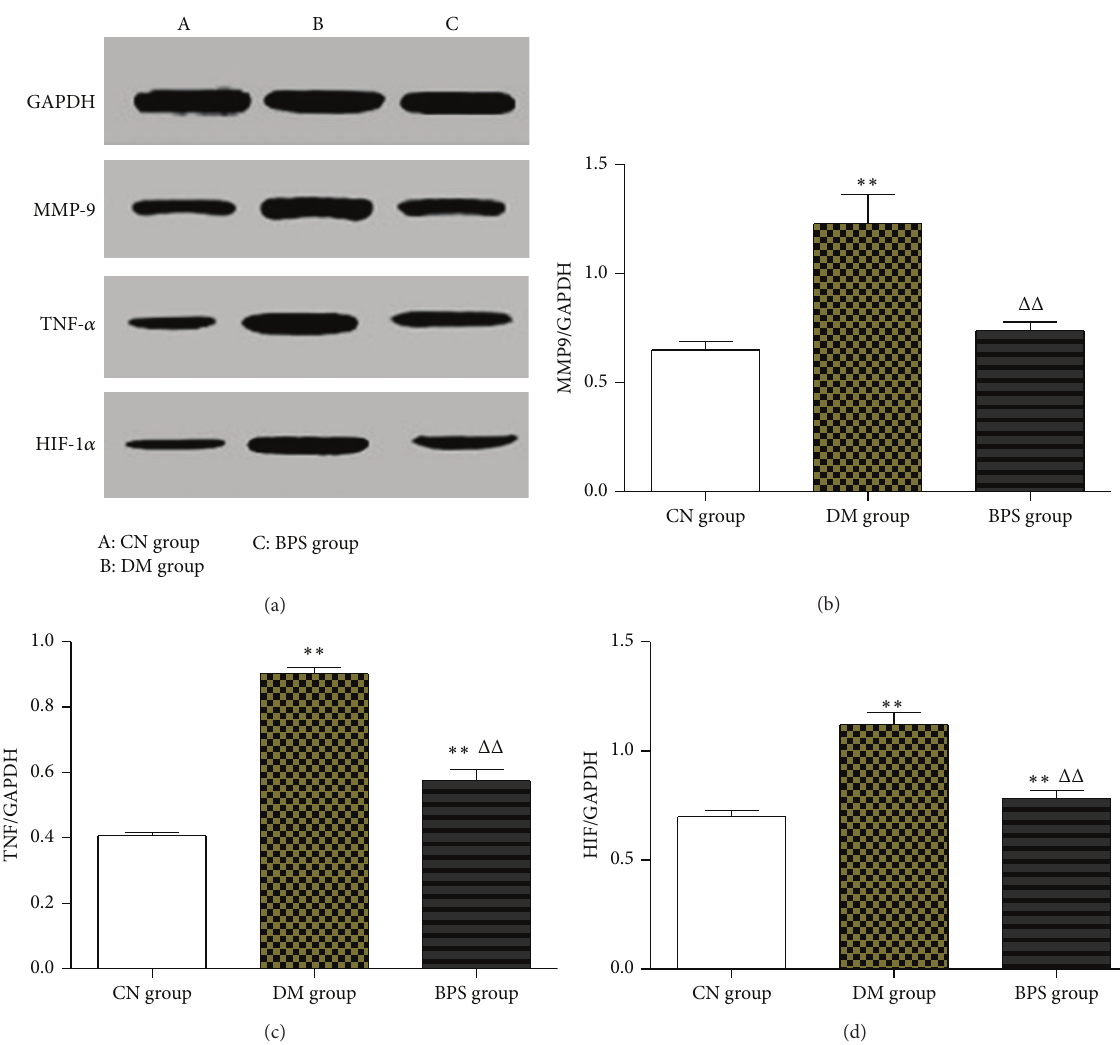
Figure 11: Protein expression levels of inflammatory factors in the myocardia. Compared with the CN group, MMP-9, TNF- 𝛼 , and HIF-1 𝛼 expression in the myocardial tissues of rats in the DM and BPS groups significantly increased ( 𝑃 < 0.01 ). Compared with the DM group, MMP-9, TNF- 𝛼 , and HIF-1 𝛼 expression in the BPS group significantly decreased ( 𝑃 < 0.01